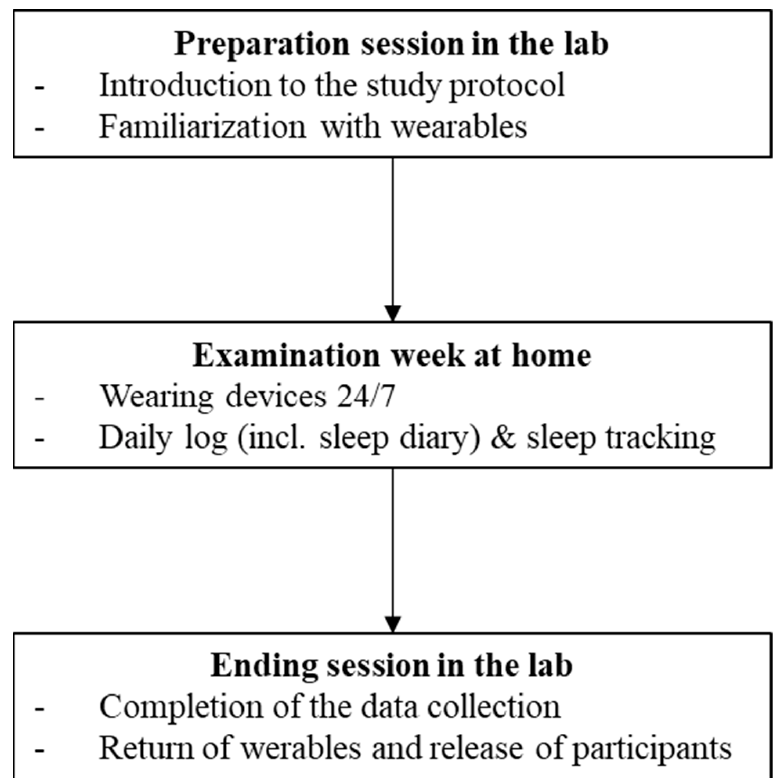
Figure 1. Flow Chart of the examined study protocol.